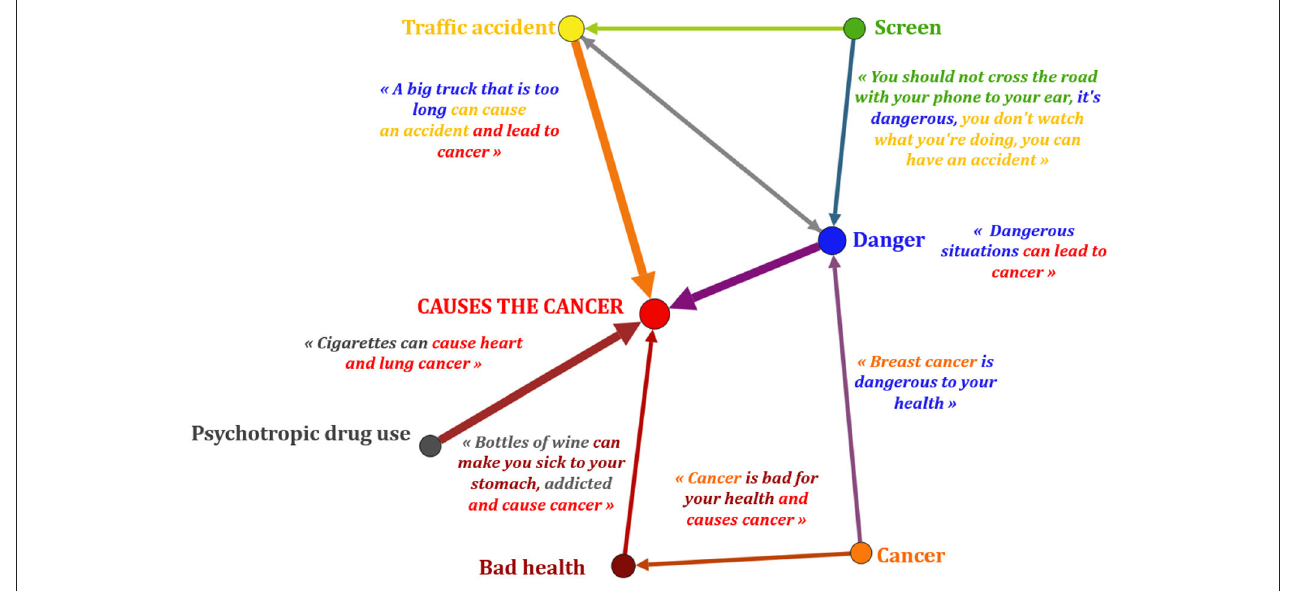
FIGURE 4 | Pictorial representation of complex conceptions systems Photonarration ≪ causes cancer ≫ Photonarration - GEPHI 9.2 © (GUCE19F). The conceptions reveal more or less important links depending on the thickness of the line between different determinants unfavorable to health. Example: “screen”; “danger”; “accident”: these determinants are associated with each other, the child emphasizes their link and their causal effect: using their phone while crossing can be dangerous and can cause an accident.